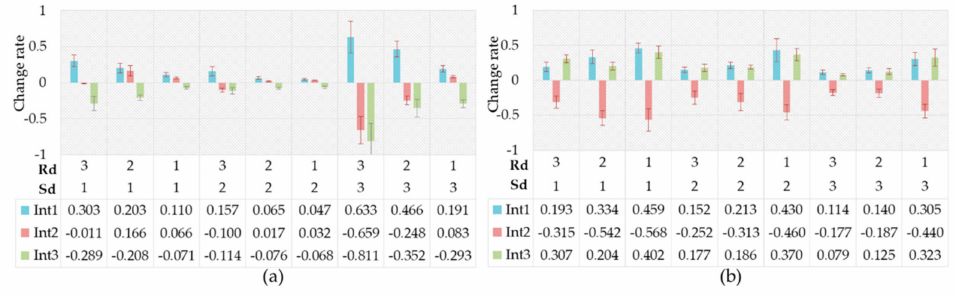
Figure 16. Change rates of driving intention probability. ( a ) Caused by fear; ( b ) Caused by